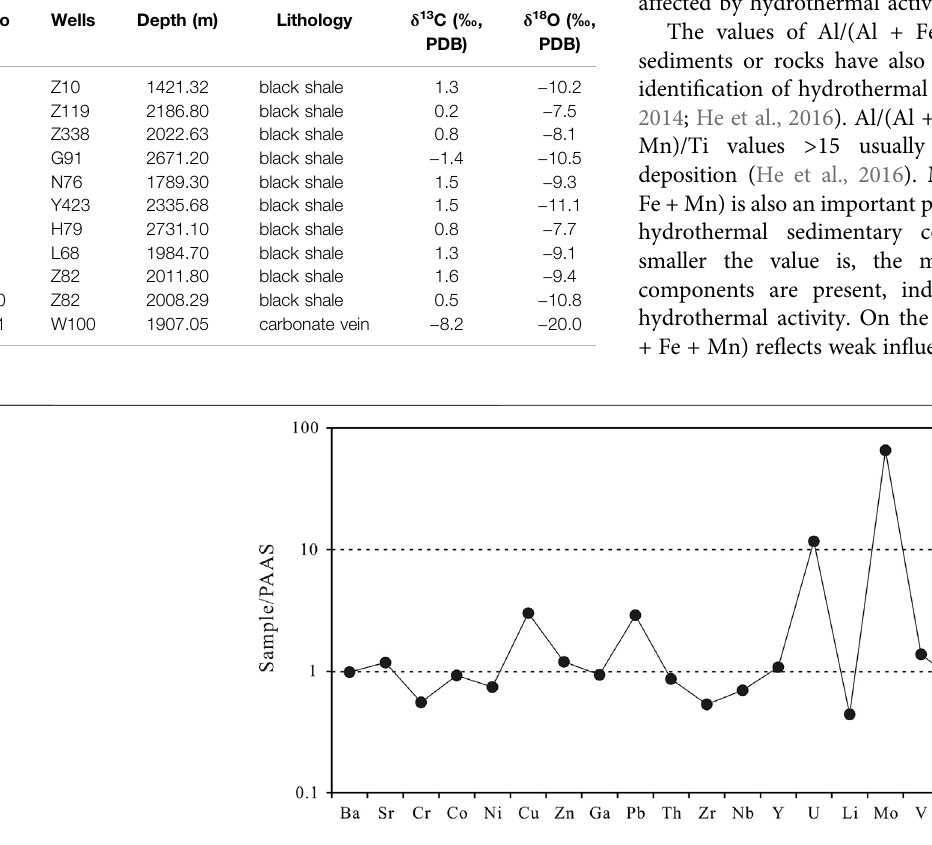
FIGURE6 | PAAS standardizationof average trace elementcontentsofthe Chang 7 black shale ofYanchang Formation, Ordos Basin. The data ofPAAS arefrom Taylor and McLennan (1985).